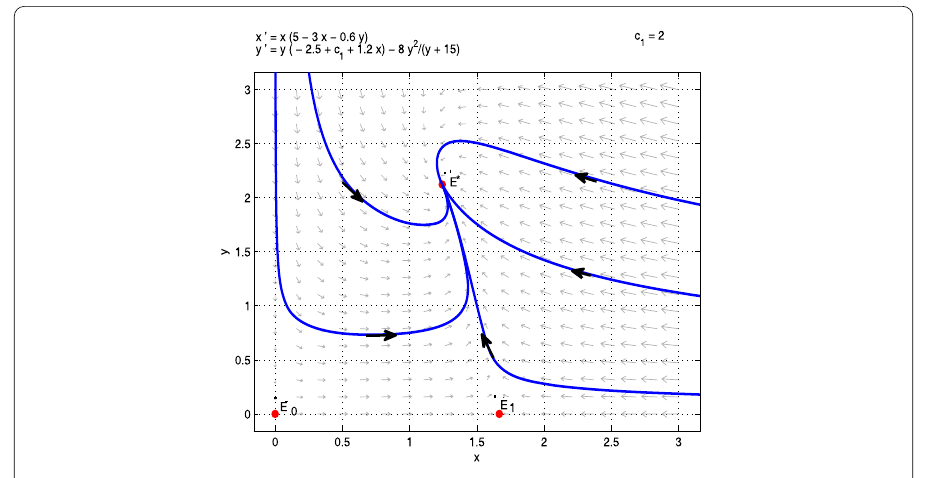
Figure 3 Dynamic behaviors of system (4.2) if c 1 = 2